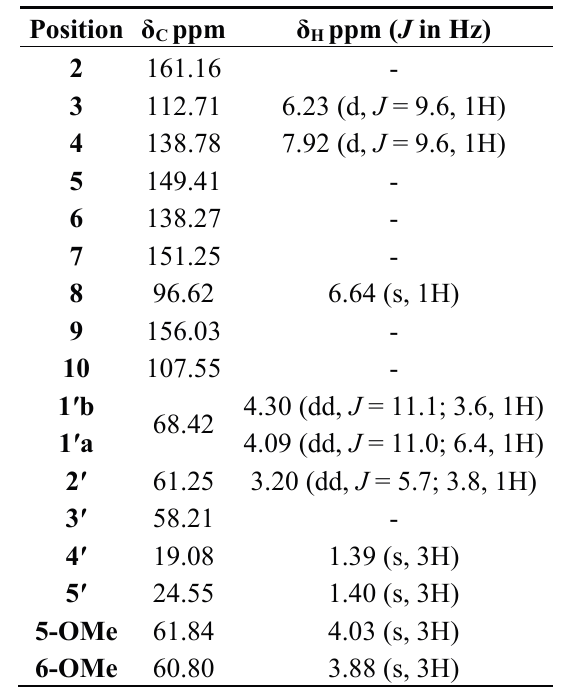
Table 2. 1 H- (400 MHz) and 13 C- (100 MHz) NMR data of 5,6-dimethoxy-7-(2 ′ ,3 ′ -epoxy- 3 ′ -methylbutyloxy)coumarin (CDCl 3